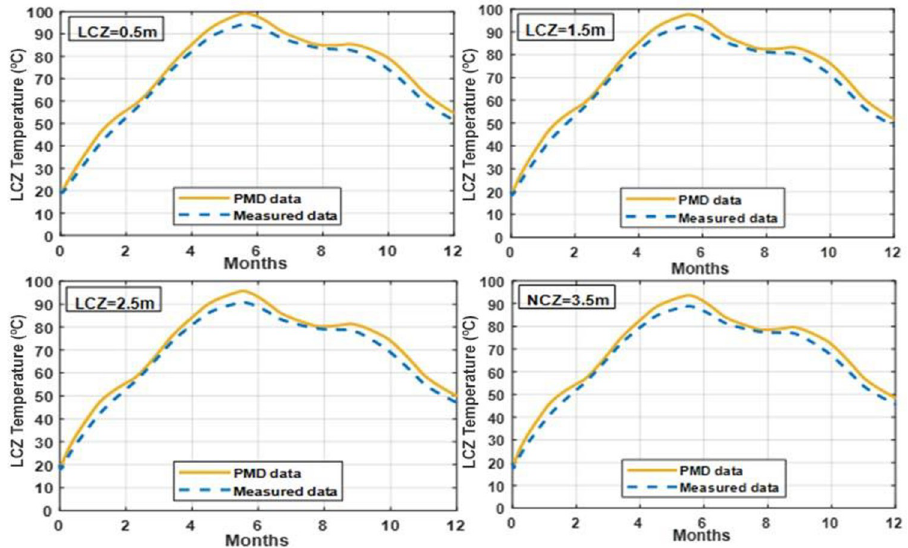
Fig 15. Effect of different thickness of LCZ on the temperature of LCZ with UCZ = 0.3m and NCZ = 1.0m under PMD and measured climatic conditions of Lahore.